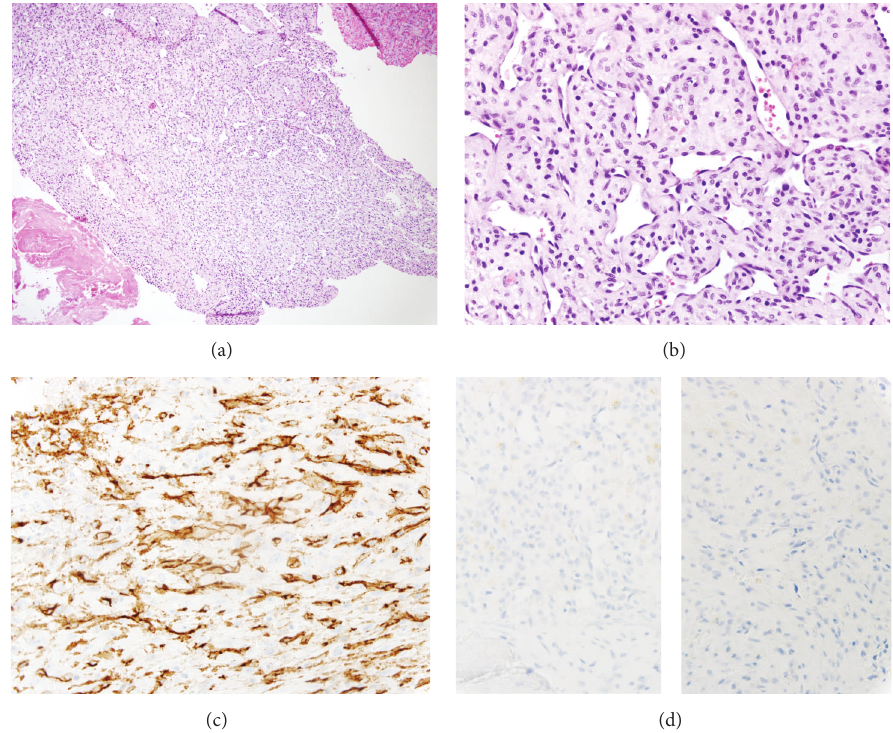
Figure 4: Hemangioma of the cerebellopontine angle. (a)-(b) Microscopically, the tumor cells are cytologically bland with vascular proliferation (H&E, (a) × 100; (b) × 400). (c)-(d) Immunohistochemistry, the tumor cells are positive for CD31 ((c), × 400) as well as negative for inhibin ((d) left, × 400) and EMA ((d) right, × 400). The cells are also positive for CD34 and negative for GLUT-1 (not